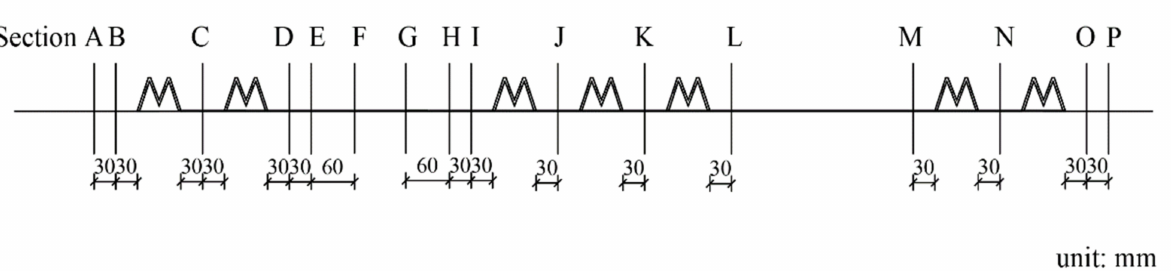
Figure 5. Settings of the cross-section in the artificial reef